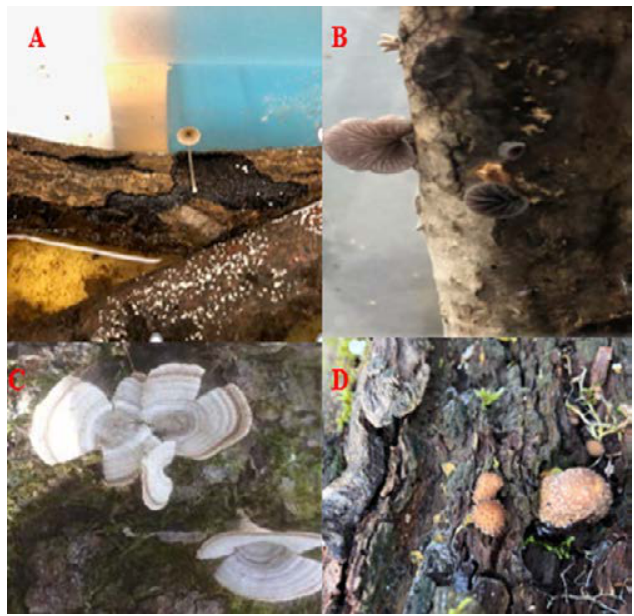
Fig. 3. Different species of wood-decay fungi collected from the incubation chambers and the field; A. Pluteu romellii , B. Resupinatus alboniger , C. Lenzites betulinus and D. Lycoperdon pyriforme